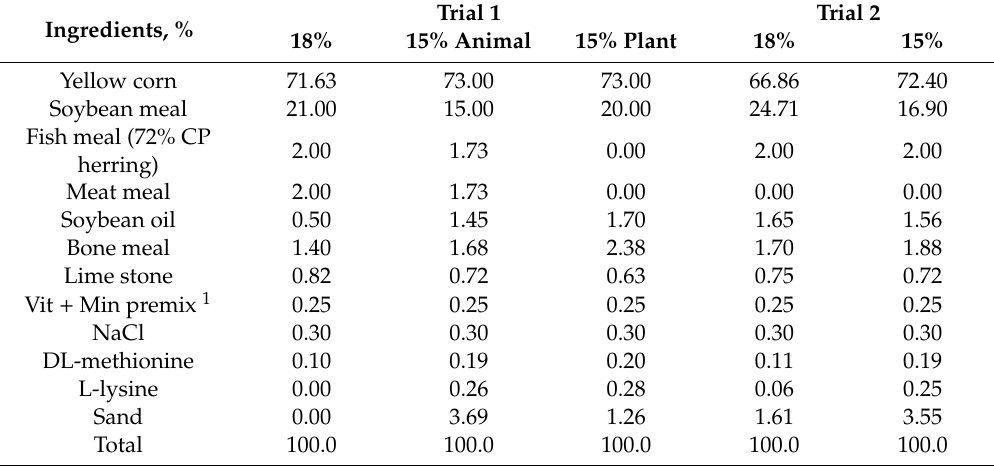
Table 1. Composition, and calculated and analyzed nutrients of diets in trial 1 and